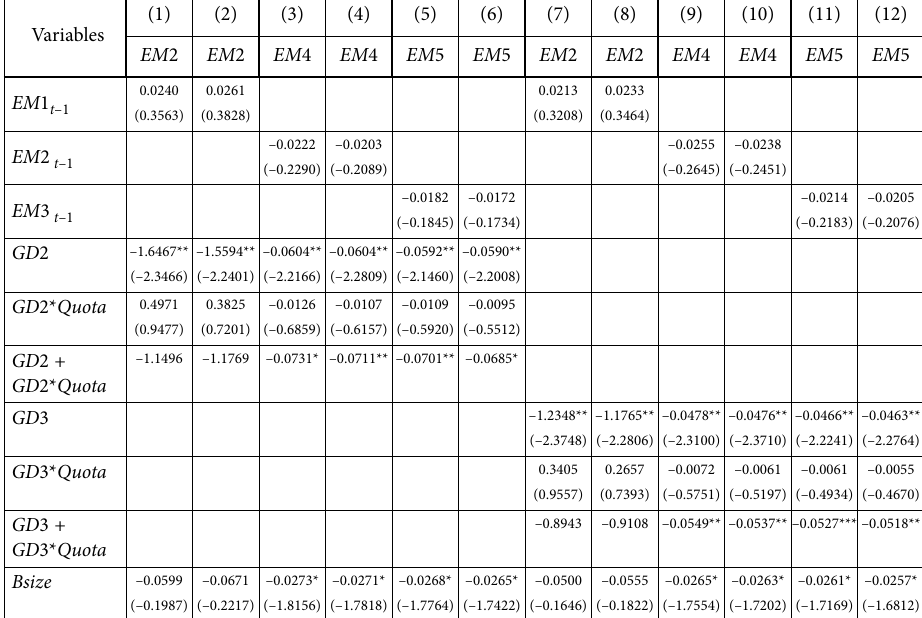
Table 8. Gender diversity and quotas and earnings management (GMM